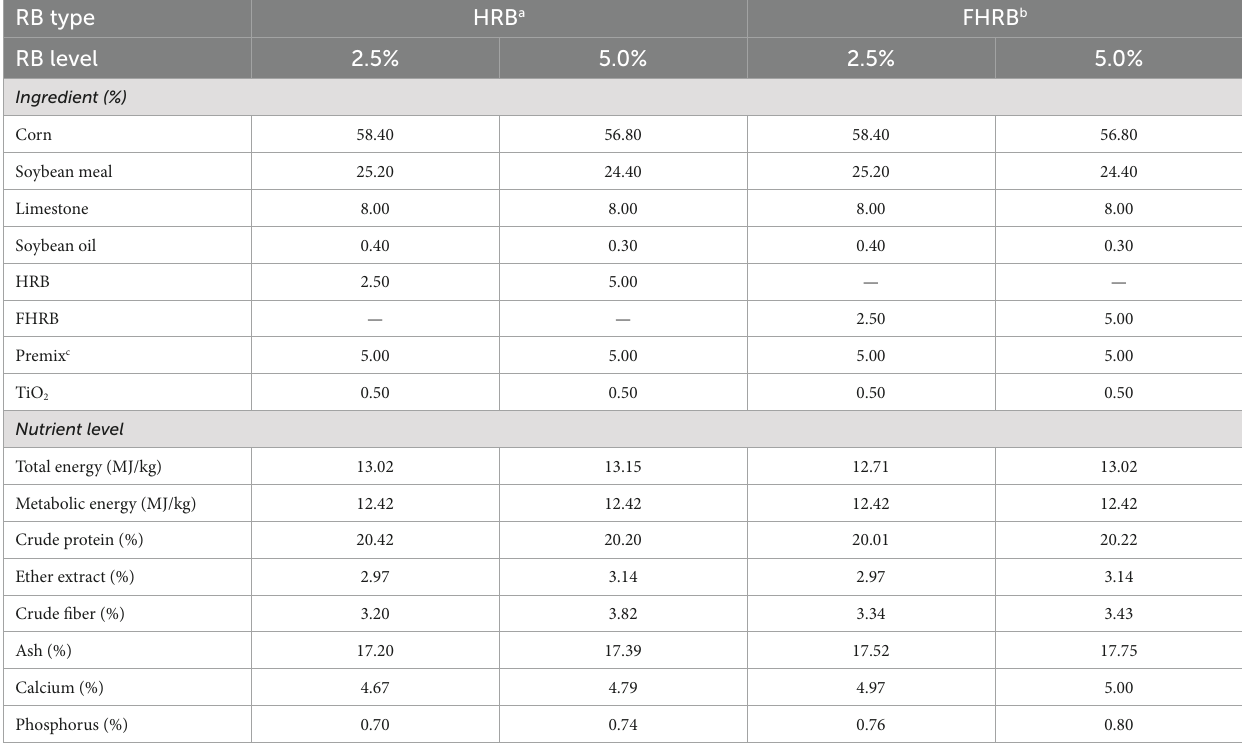
TABLE 1 Composition and nutrient level of the experimental